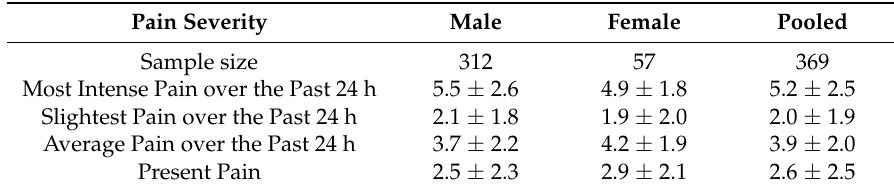
Table 4. Pain severity a of the Hong Kong construction workers (Mean ±